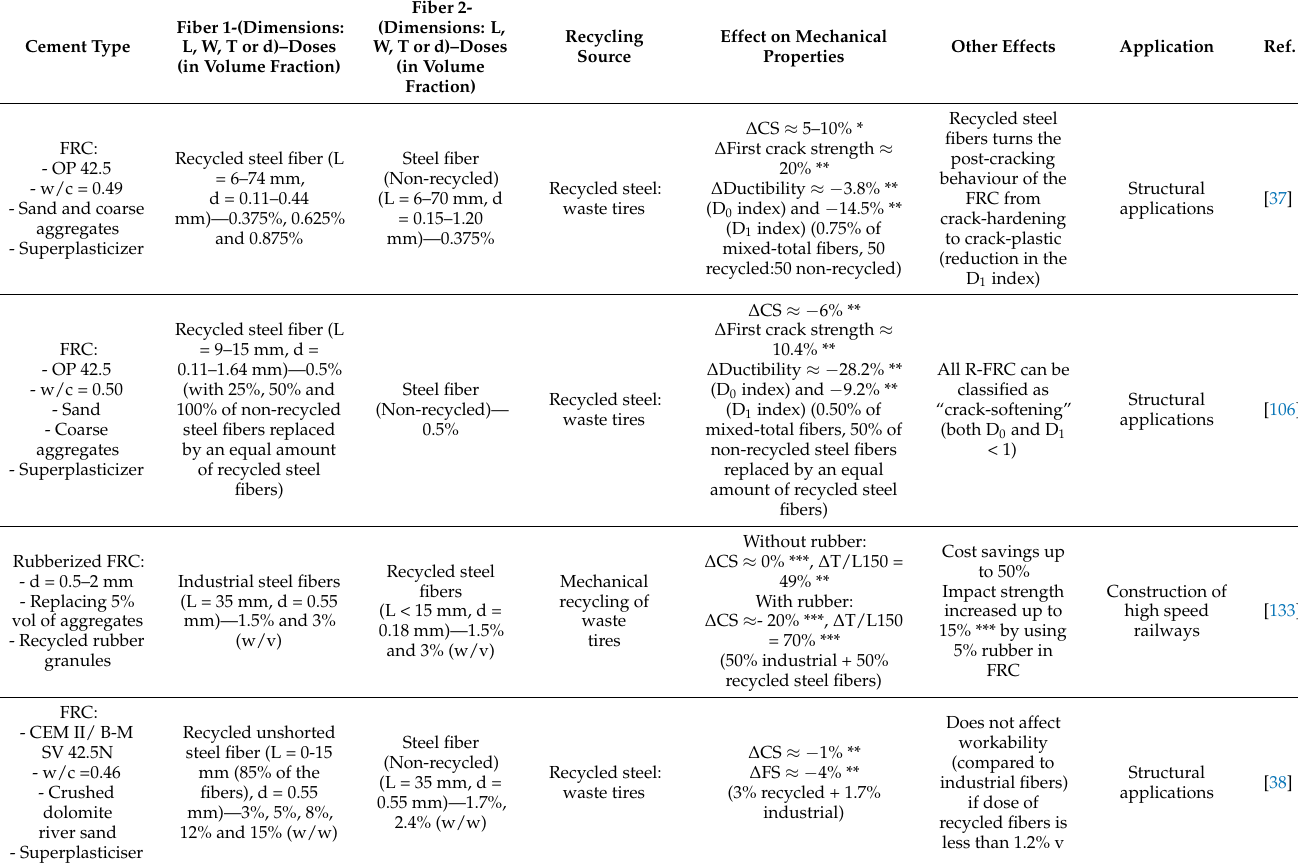
Table 2. Recycled metallic fibers (RMF) in hybrid